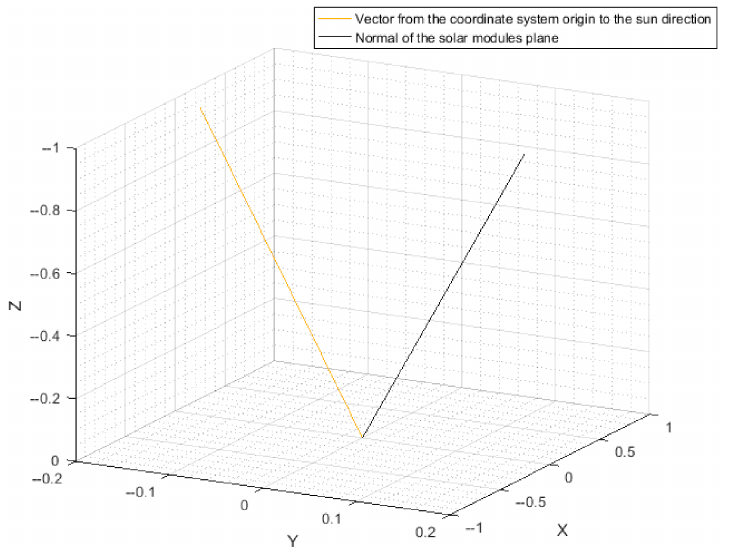
Figure 15. Local vector from the three-dimensional Cartesian coordinate system origin to the sun direction and the normal vector of the solar modules